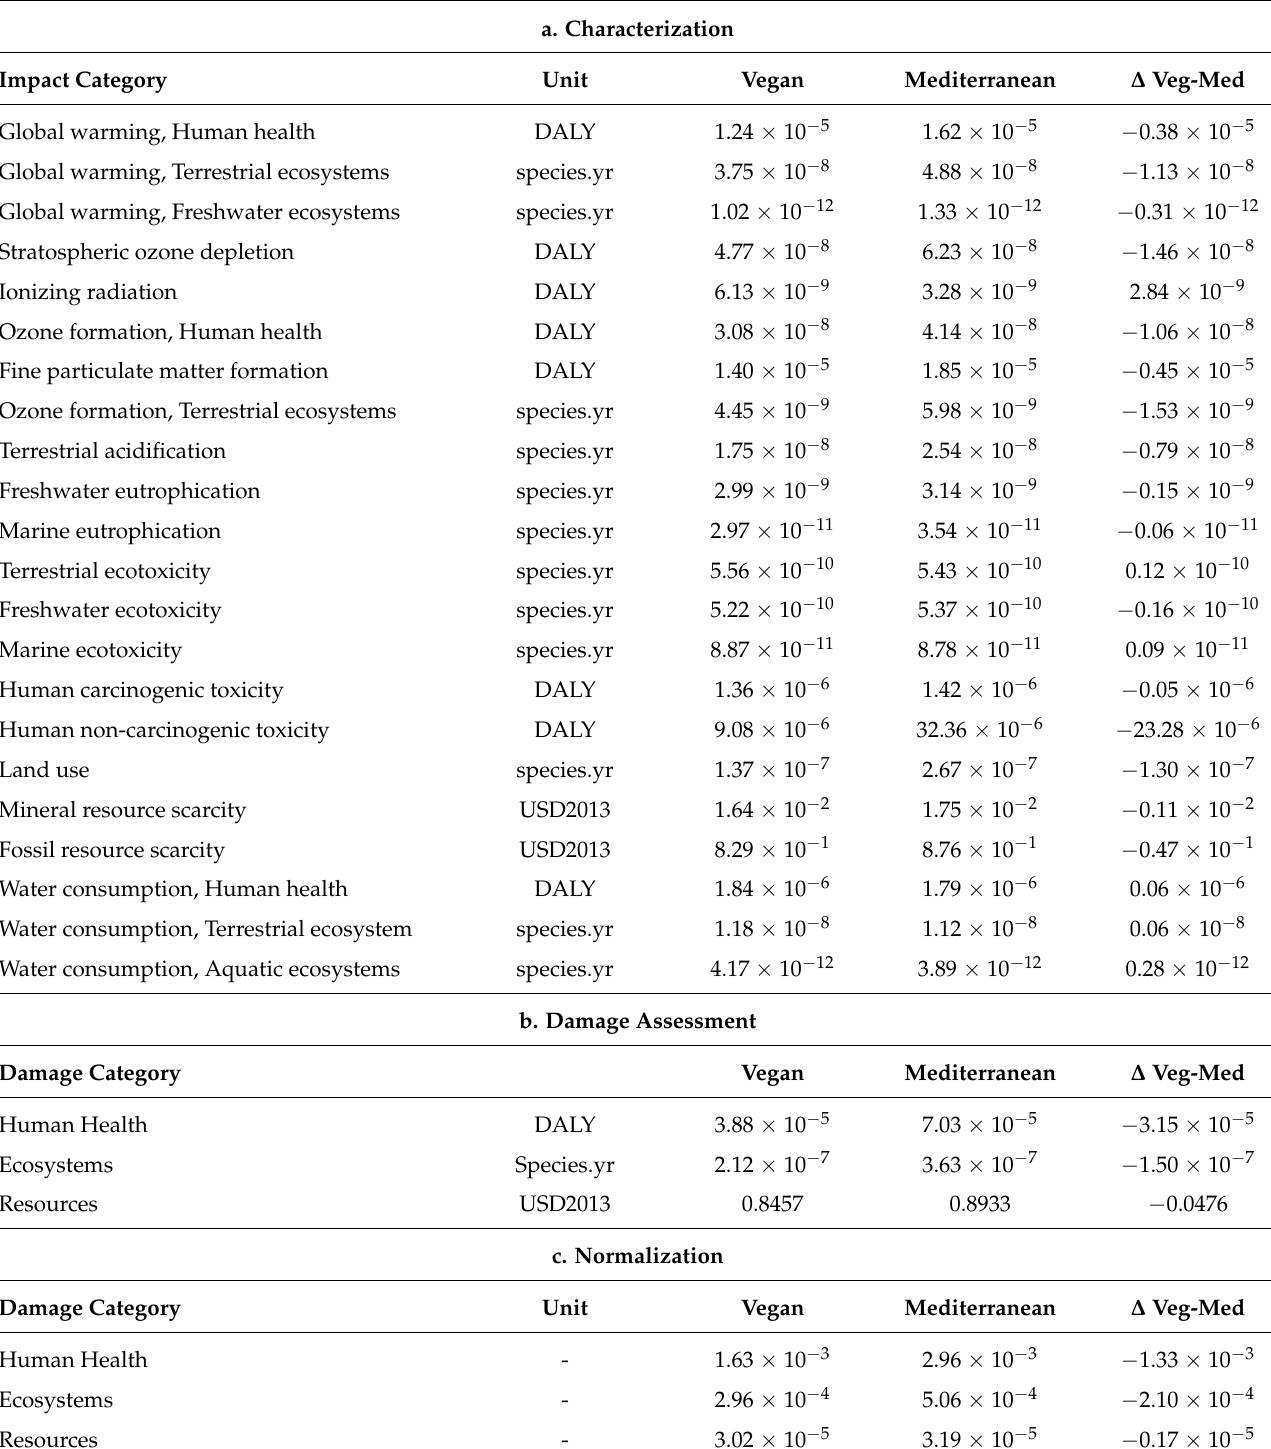
Table 2. Life Cycle Assessment Calculation (LCIA), proposed for steps. (DALY: disability-adjusted life years; species.yr: loss of species during a year; USD2013: US